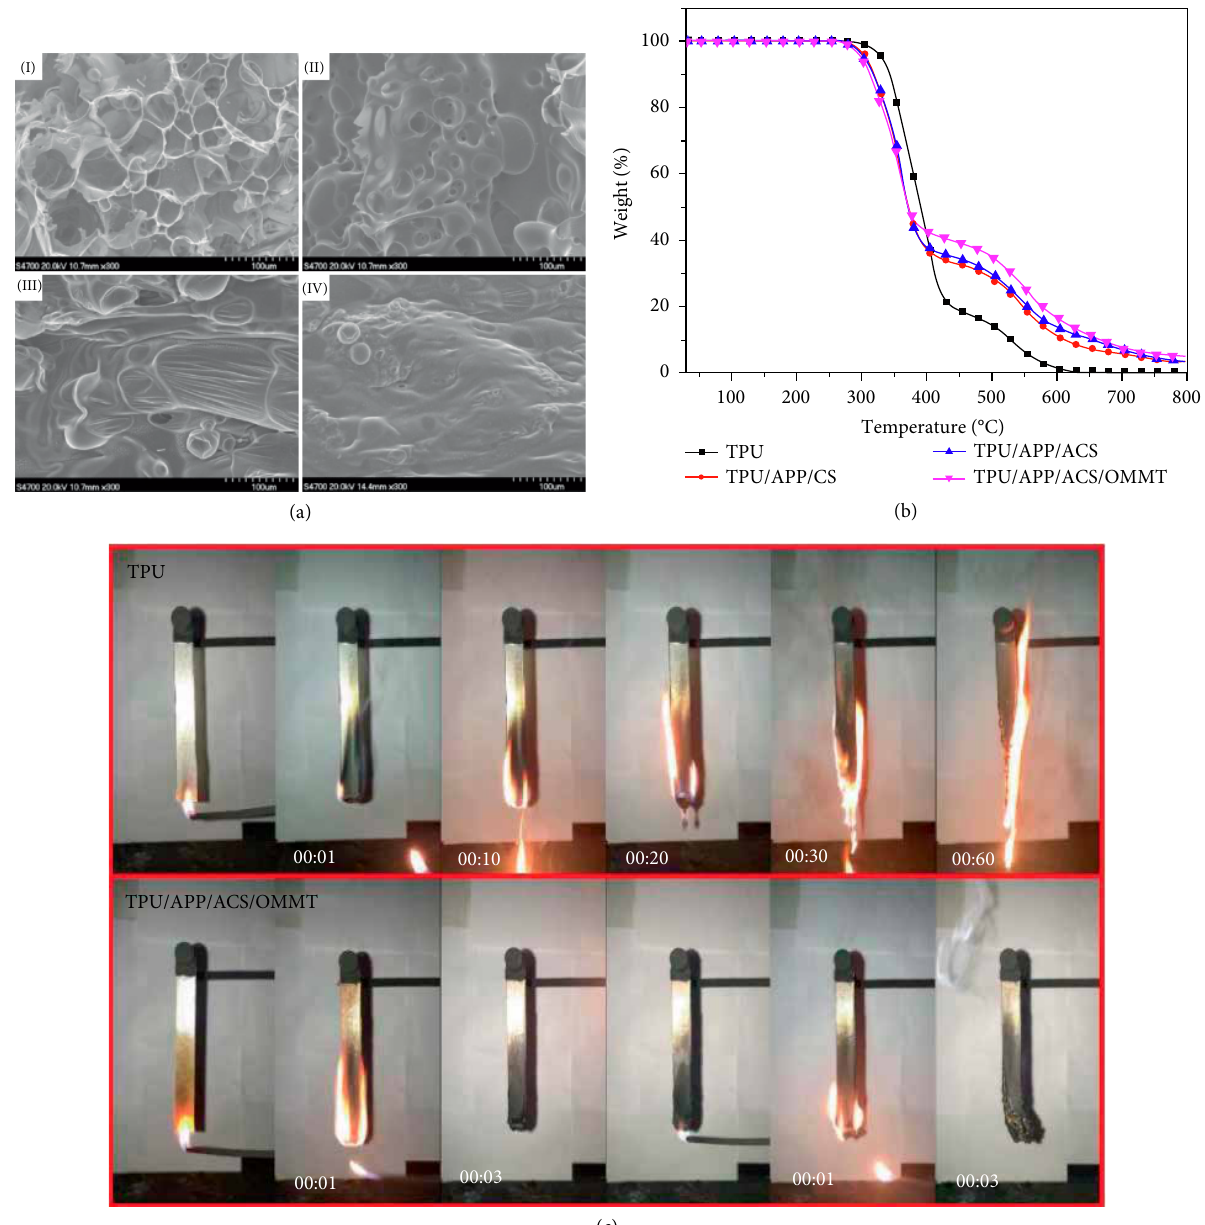
Figure 6: (a) SEM images of the surfaces residues of (I) neat TPU, (II) TPU/APP/CS, (III) TPU/APP/ACS, and (IV) TPU/APP/ACS/OMMT. (b) TGA curves of TPU composites in air. (c) Screenshots from UL-94 test videos of TPU and TPU/APP/ACS/OMMT samples. Adapted from